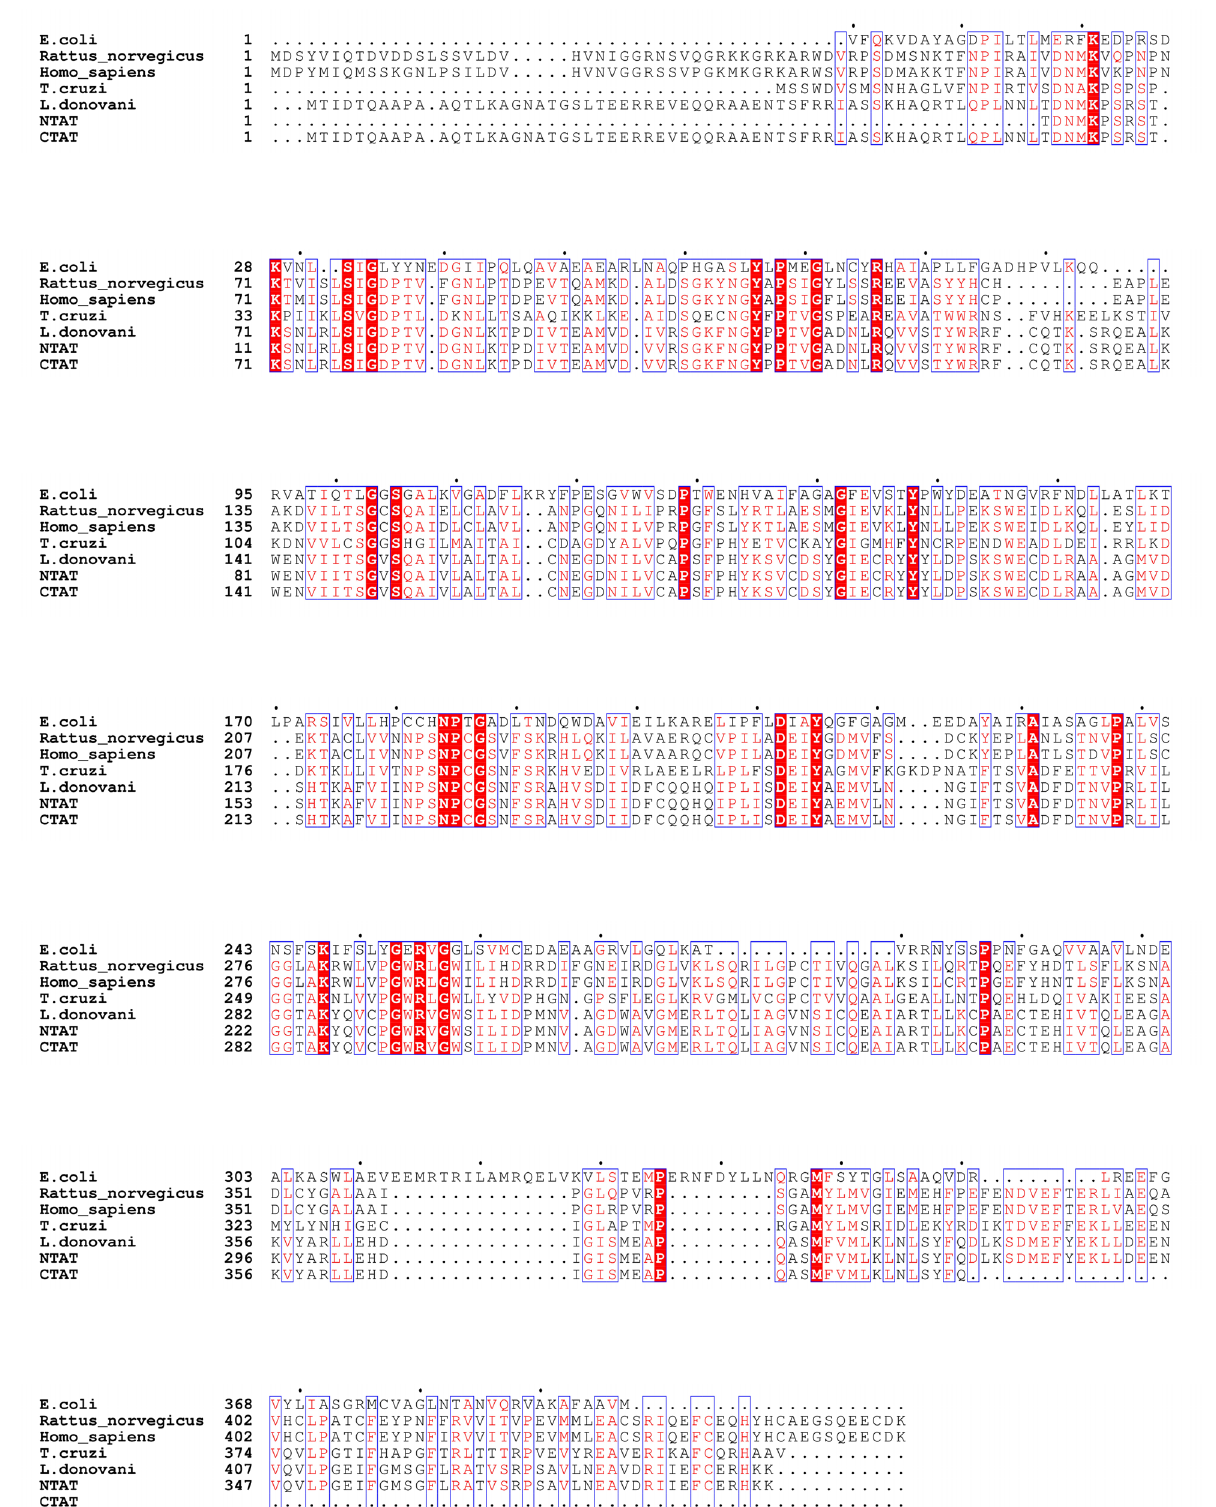
Figure 2. Multiple Sequence alignment analysis: The figure shows the sequence alignment of tyrosine aminotransferase of L. donovani with E. coli (18.66% identity), Rattus norvegicus (35.70% identity), Homo sapiens (35.01% identity) and T. cruzi (43.66% identity) . It is observed that the N-terminal of TAT from L. donovani has a very little identity with other TAT sequences but the C-terminal shows a large number of identical sequences conserved across the organisms. The red highlighted boxes with residues in white font depict identical and conserved amino acid residues whereas the blue boxes that are non-highlighted represent similar amino acid residues in red